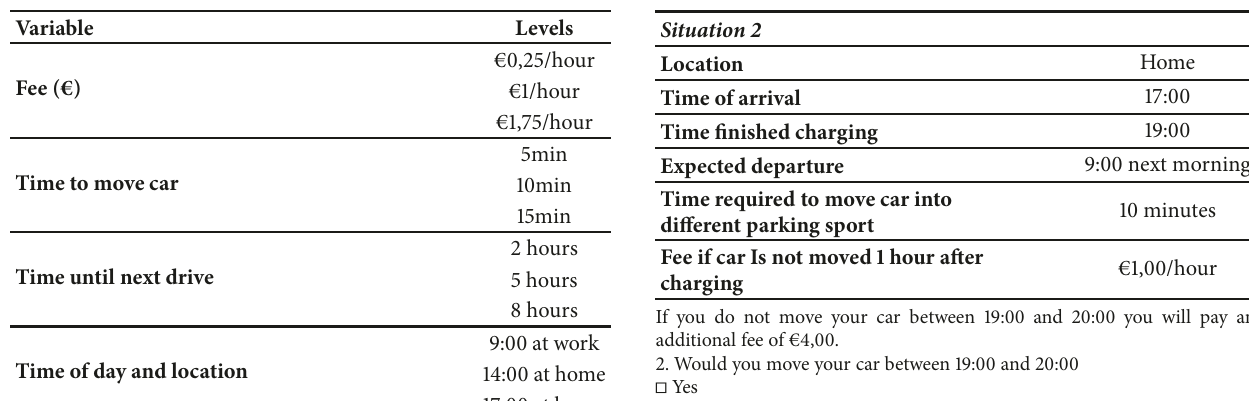
Table 1: Overview of variables used in stated choice experiment. Table 2: Exemplary choice